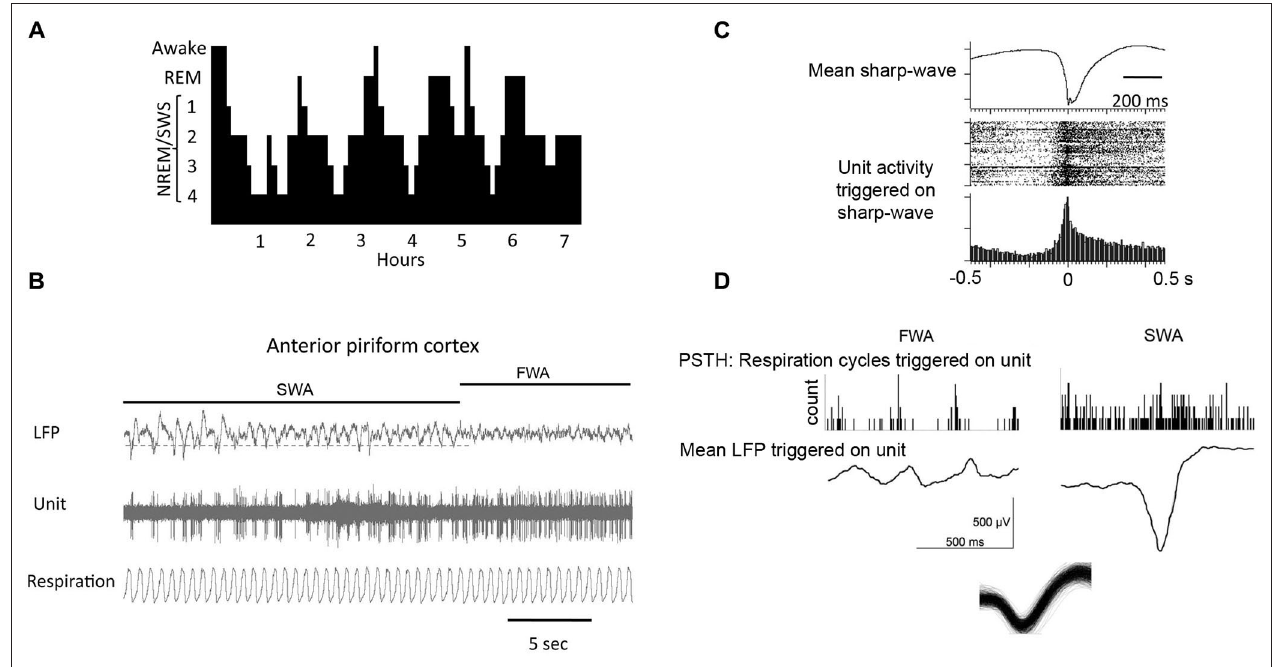
by the raster plot and peri-stimulus time histogram. (D) Piriform cortical single-unit and LFP activity are decoupled from respiration during slow-wave sleep compared to waking. Histograms show respiratory events as a function of single-unit spiking. LFP’s are mean waveforms triggered on single-unit spikes. Overdrawn waveform of single-unit used for analysis in D in shown at